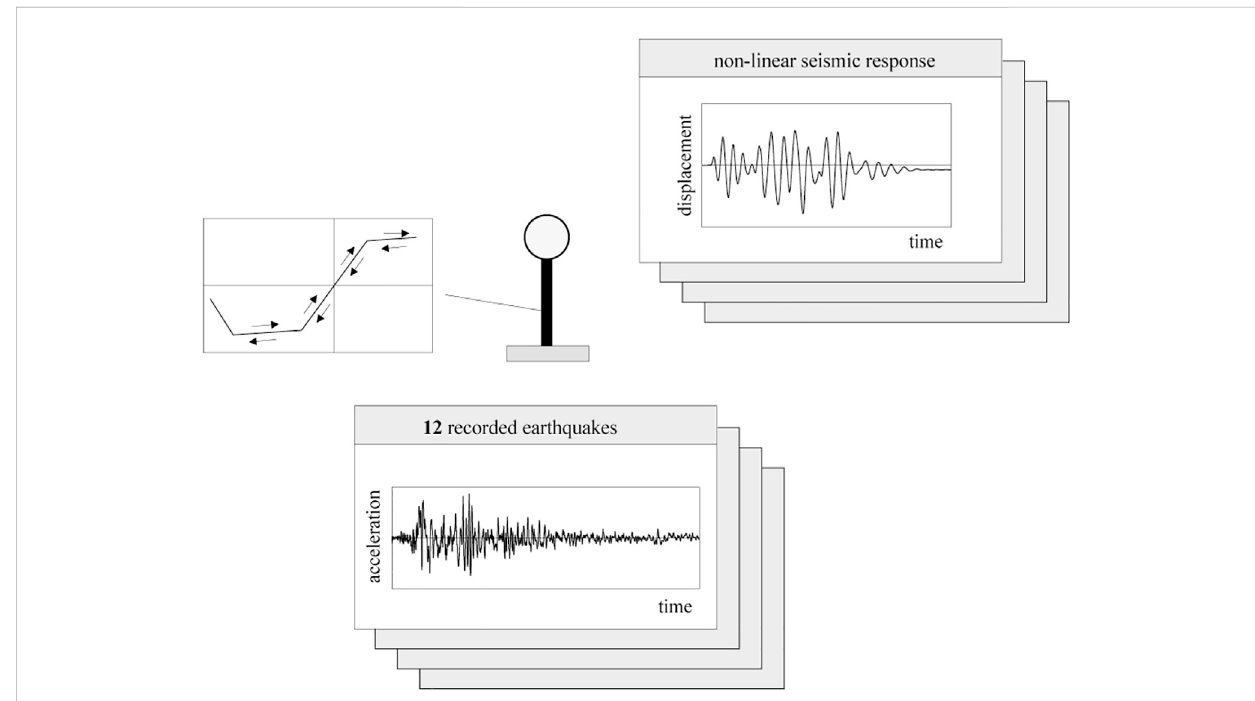
FIGURE 6 Schematic description of the methodology for the case of non-structural walls located at the ground level.